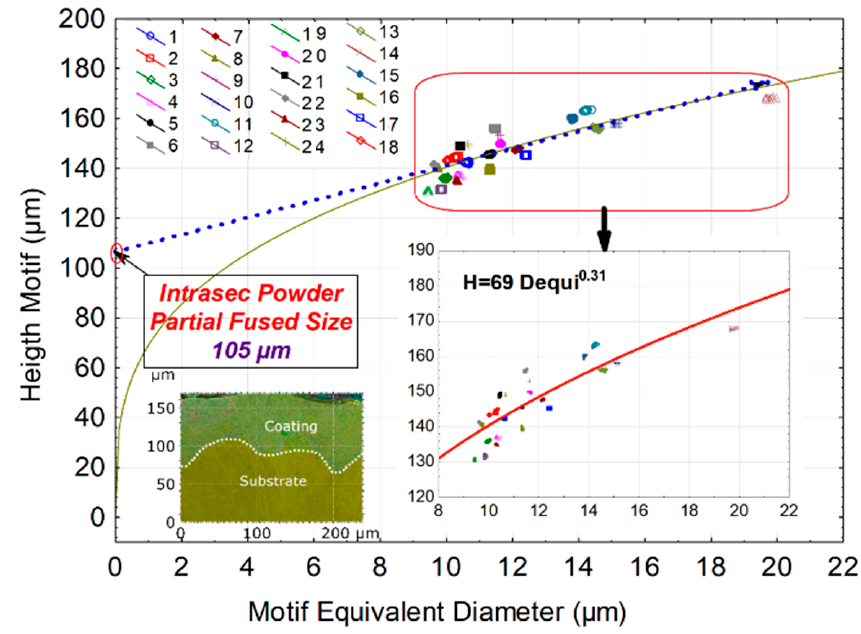
Figure 18. Graphics of height motif amplitude (H) versus motif equivalent diameter (D equi ) of partial melting zones.